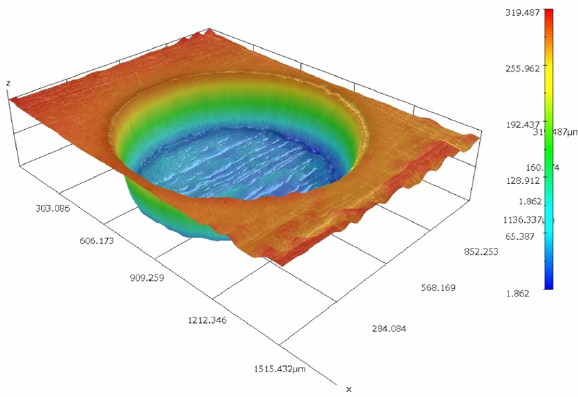
Figure 5: 3D profile of the second sample for trajectory No. 1.